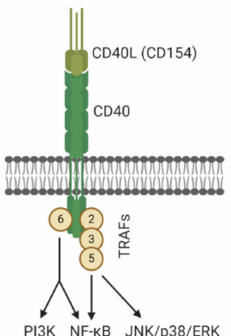
Figure 1. Illustration of CD40 / CD40L regulated intracellular signaling. CD40 receptor activates different typesofTRAFsuponstimulationandtriggerssignalingcascadesincludingthePI3K,NF- κ B,andp38 / ERK pathways. (Figure created with